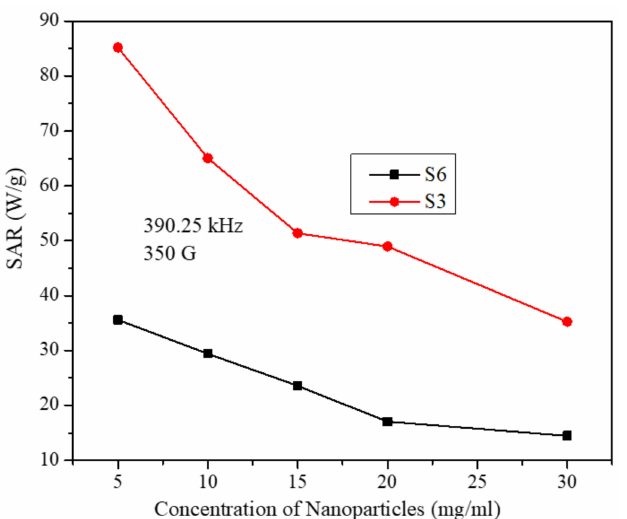
Figure 9. SAR values as a function of particle concentration for samples S3 and S6 at fixed field frequency and strength. (The lines in the figure are just to guide the